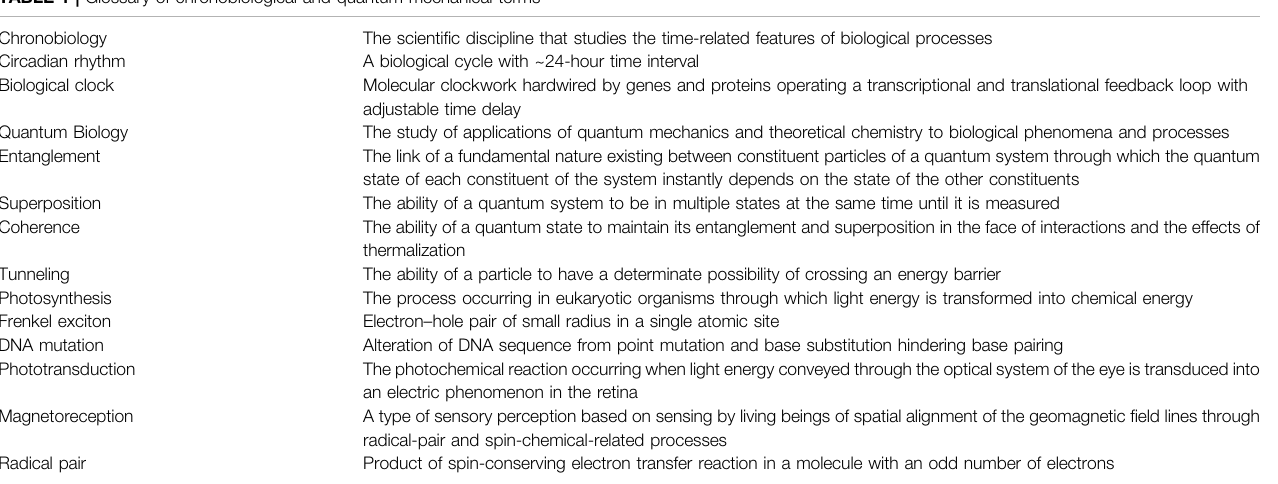
TABLE 1 | Glossary of chronobiological and quantum mechanical terms